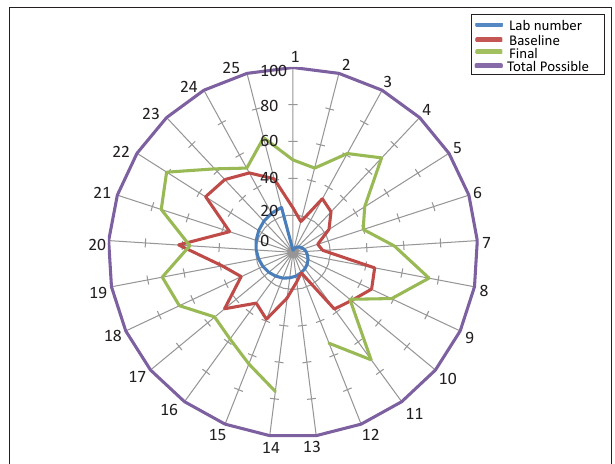
All laboratory performance at baseline and